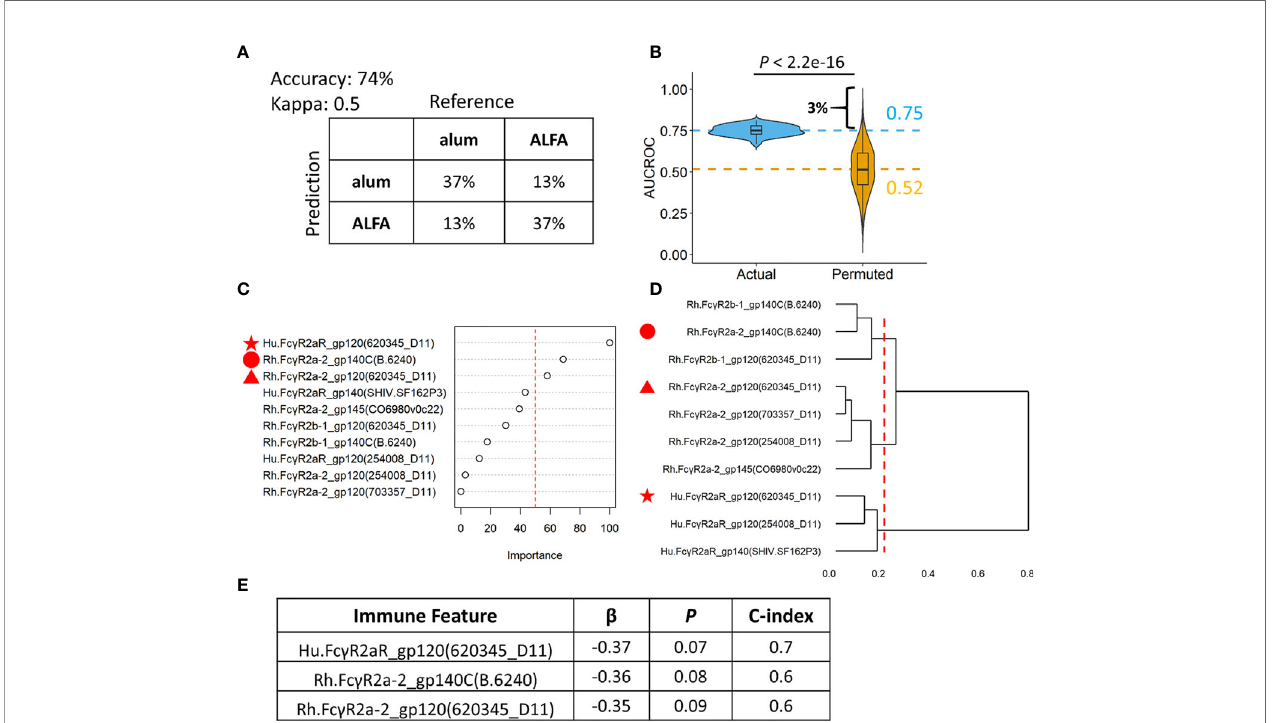
FIGURE 4 | Random forest models revealing individual level differences between ALFA and alum. (A) Prediction accuracy, kappa, and confusion matrices. The rows of confusion matrices represent the predicted adjuvant arms, whereas the columns indicate the actual adjuvant arms. (B) Comparison of AUCROC values from 100 repetitions of 100 times repeated 5-fold cross-validation using actual (blue) versus permutated (yellow) adjuvant labels. Dashed line represented the mean AUCROC values. (C) Immune feature importance in random forest models. (D) Hierarchical clustering on immune features used in random forest models. (E) Cox regression analysis on three most important immune features identi fi ed by random forest